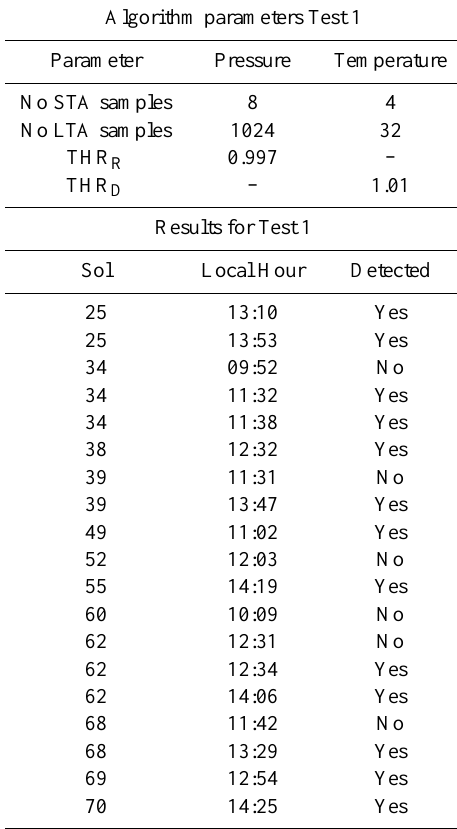
Algorithm parameters Test 1